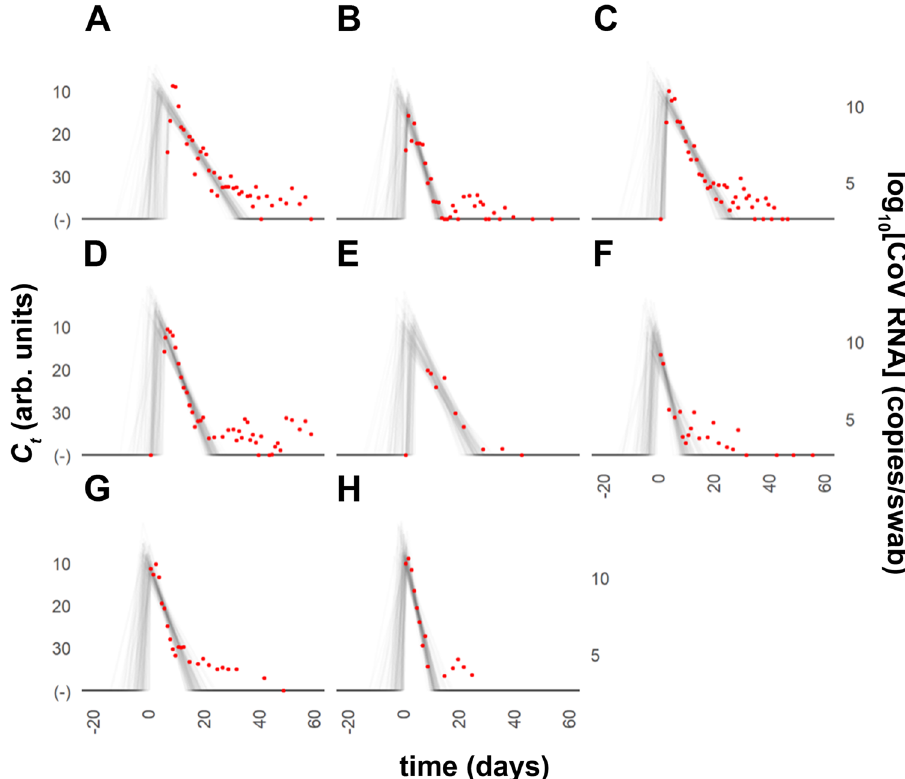
Fig. 4 Modeled nasal swab SARS-CoV-2 C t trajectories for individual study participants. Informative priors model plots (gray) for C t values and estimated trajectories for infections; each red circle corresponds to one observation; T (d) indicates the time since the minimum C t value (highest viral load). A subject 2; B subject 21; C subject 38; D subject 48; E subject 63; F subject 83; G subject 84; H subject 85.